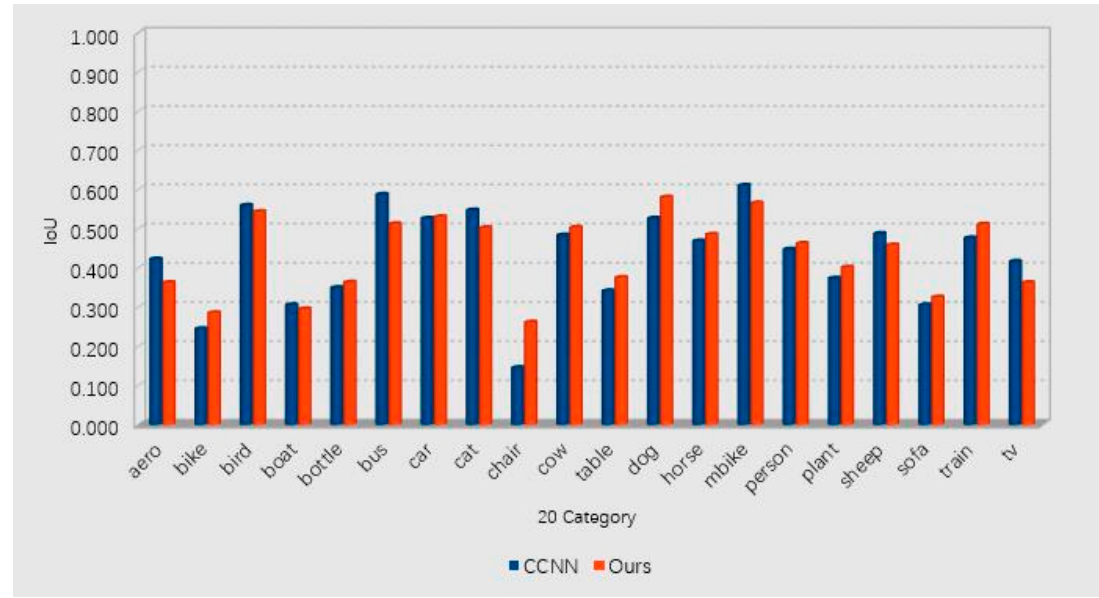
Figure 13. RMNN and CCNN segmentation accuracy.